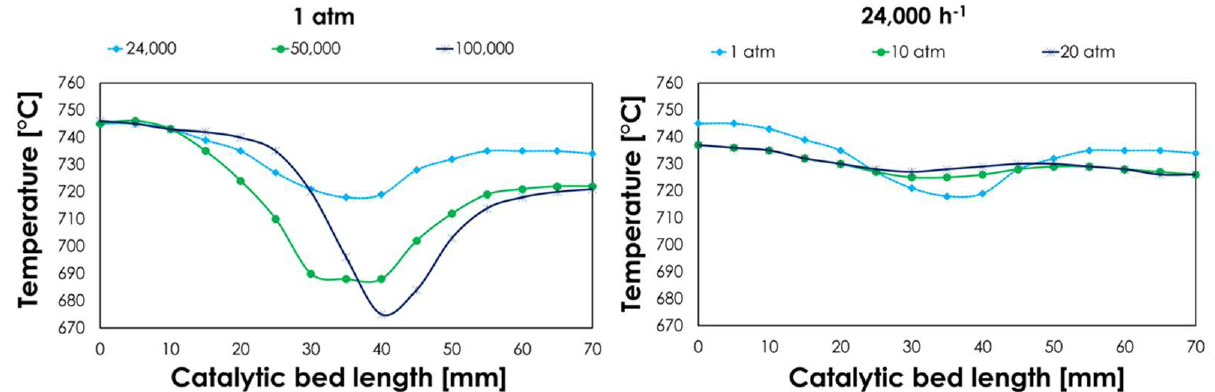
Figure 11. Temperature profile of the catalytic bed for Rh-CZOm750R750 at different pressures (left) and GHSVs (right) obtained with a sliding thermocouple.